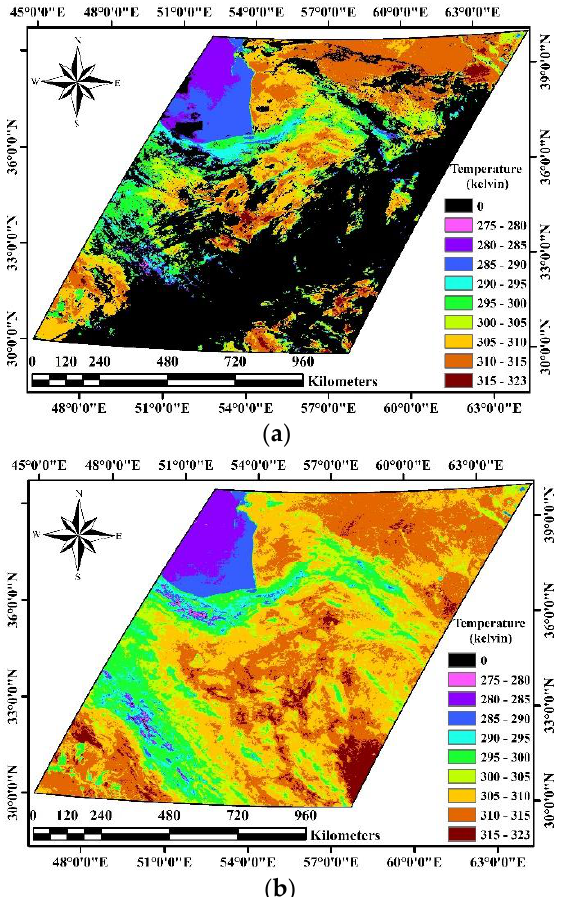
Figure 12. An LST image of the studied region before reconstruction ( a ) and after reconstruction ( b ) by SSA.